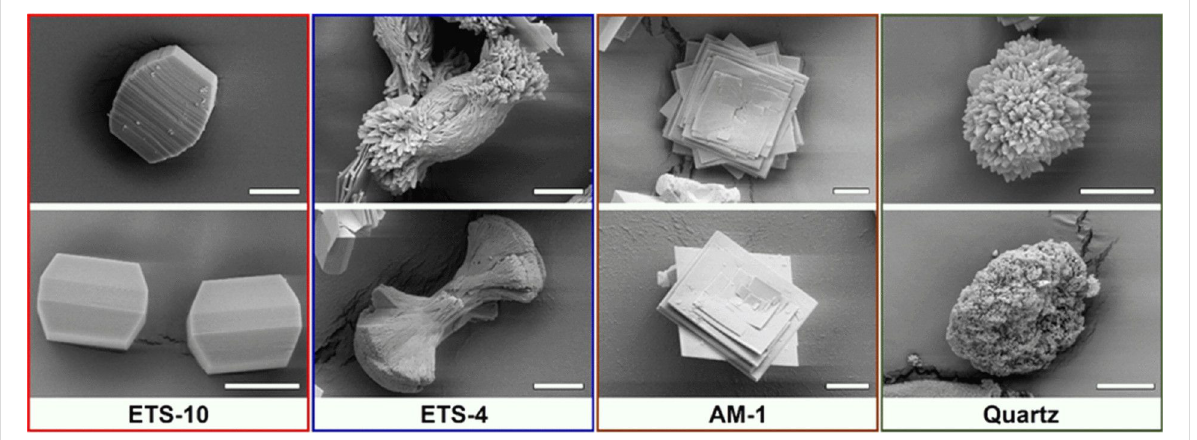
Figure 3: SEM micrographs of selected crystals representing different types of phases formed during the synthesis of titanosilicates. The assignment of each crystal shape to the corresponding phase was done based on the Si/Ti (for titanosilicates) and Si/O (for quartz) ratios obtained from the EDX analysis (see Table S8 in Supporting Information File 1). The scale bar in all images is 10 μ m.